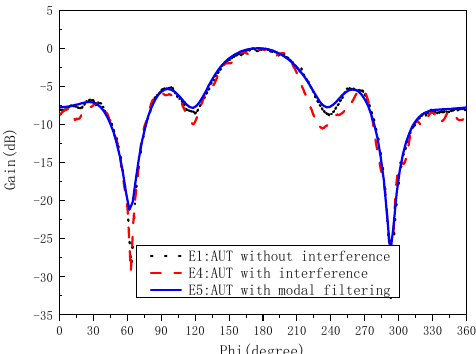
Figure 11. Comparison of the antenna pattern before filtering and after filtering.